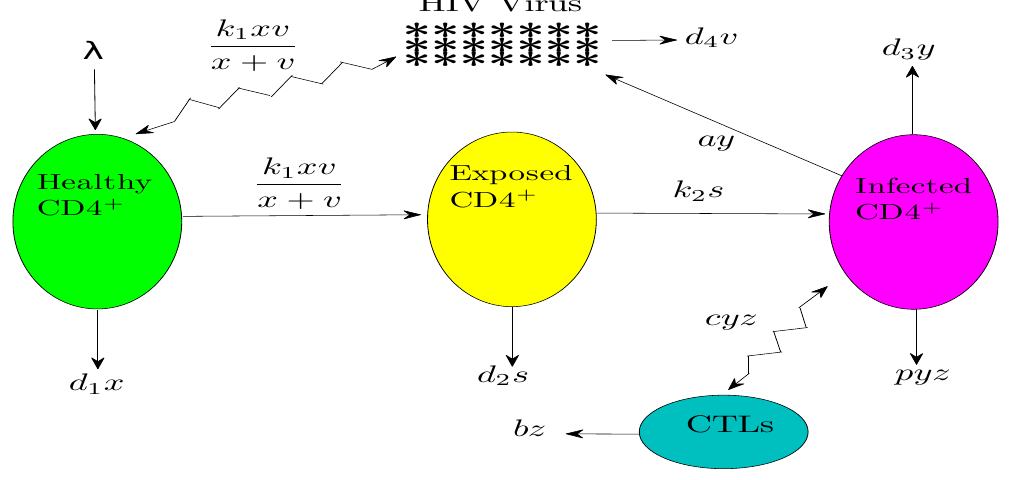
Figure 1. Schematic of the model under